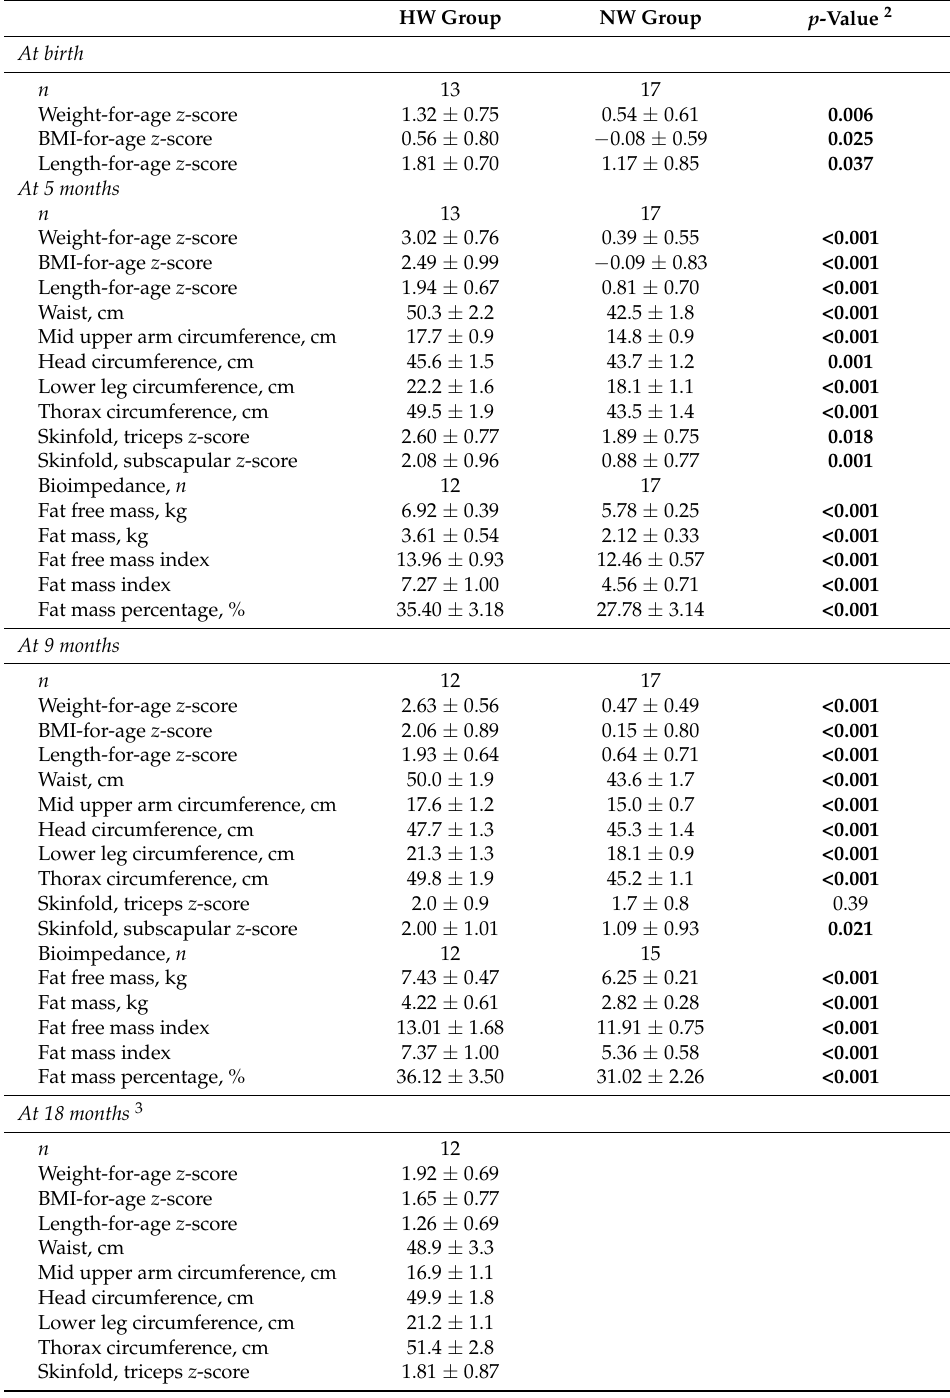
Table A1. Anthropometric values according to high weight-gain and normal weight-gain group and age 1